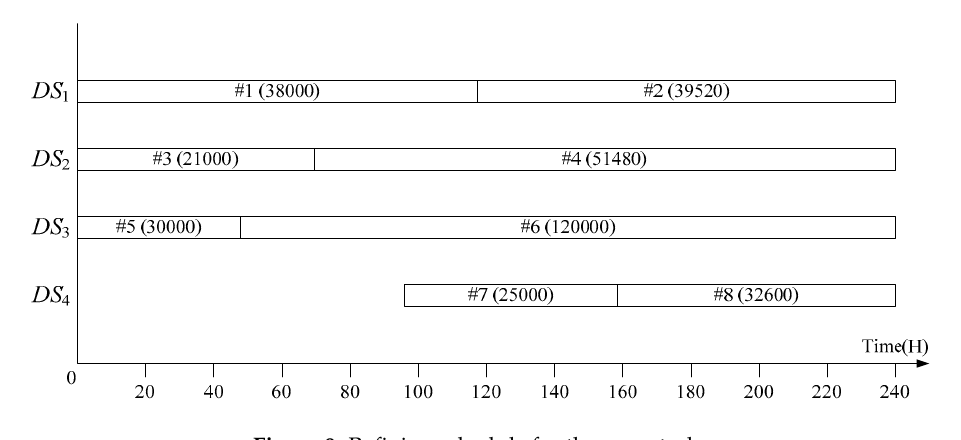
Figure 10. PN model for the case study.